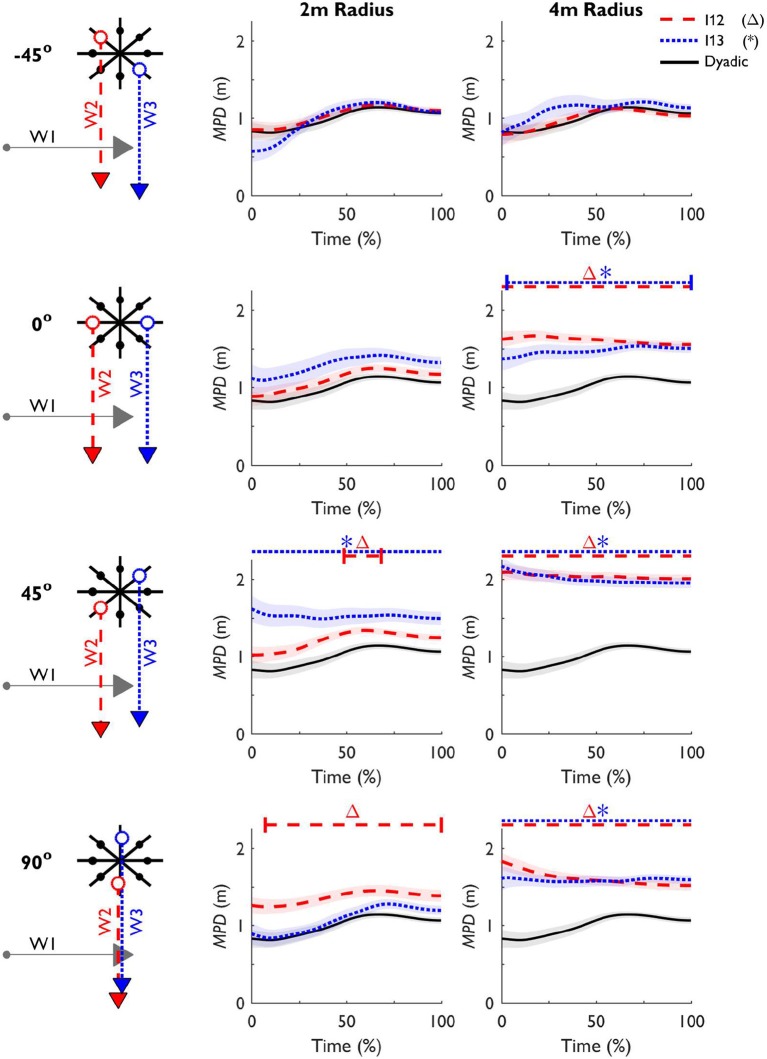
. Mean (±SE) the minimal predicted distance between Walker 1 & 2 and between Walker 1 & 3 (MPD12, dashed line; MPD13, dotted line, respectively) over time per formation. A horizontal line above the plots indicates when MPD12 (Δ) and MPD13 (*) are significantly different from the pairwise MPDDyadic (solid line) after a Bonferroni correction was applied. When the difference did not start at tstart, small vertical bars were added to indicate first instant MPD was different from MPDDyadic.